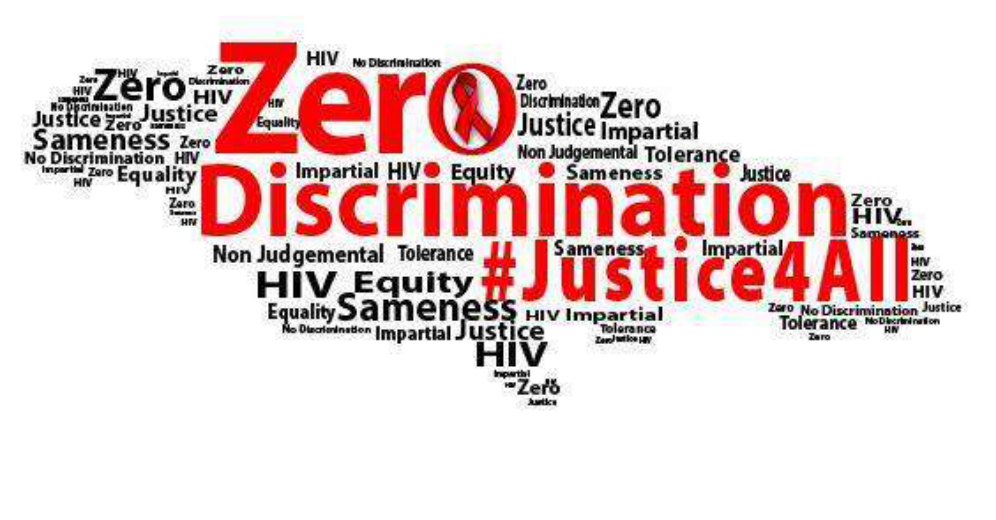
Figure 7: Logo for Jamaica’s Justice for All Programme of activities Justice for